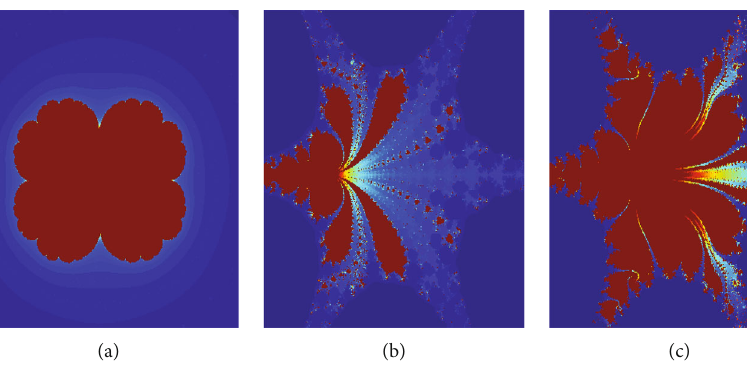
Figure 5: E ff ect of decrease in the absolute value of parameters a and c simultaneously on cubic Julia